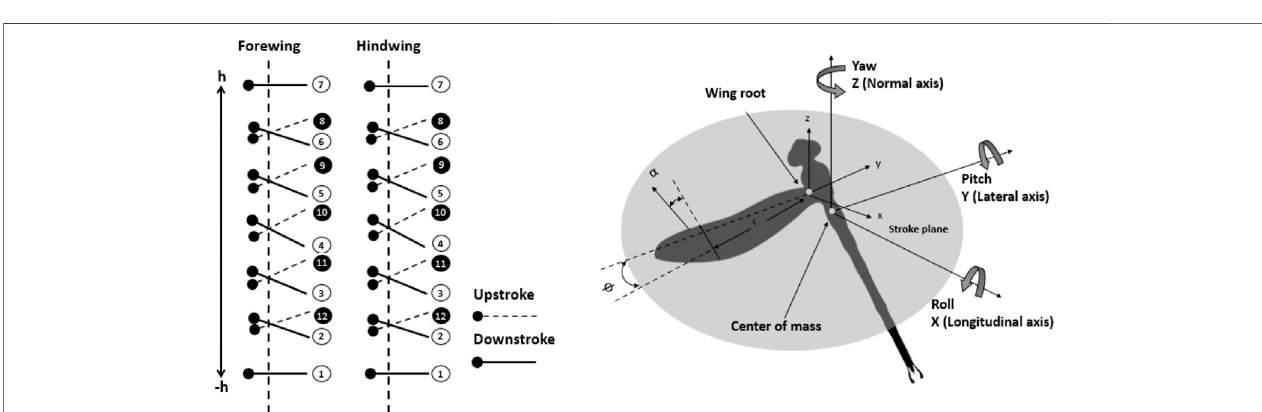
FIGURE 7 | Time history position and angles of attack of both forewing and hindwing trajectories at zero phase